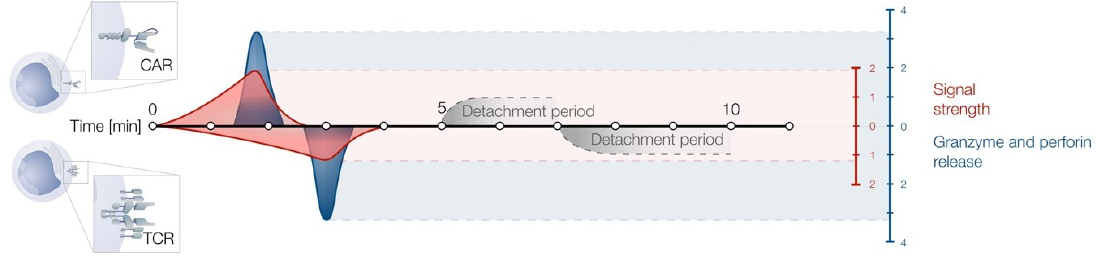
Figure 2. CAR vs T cell receptor (TCR) T cell functionality: Time interval between synapse formation and disengagement following lysis is shorter for CAR T cells compared to TCR T cells. Signal strength during engagement is stronger in CAR T cells compared to TCR T cells. Quantified granzyme and perforin release during engagement was also comparable, despite the difference kinetics. Units are depicted relative to fold change. Granzyme and perforin release depicted in blue. Signal strength depicted in red. (Adapted from [51]).